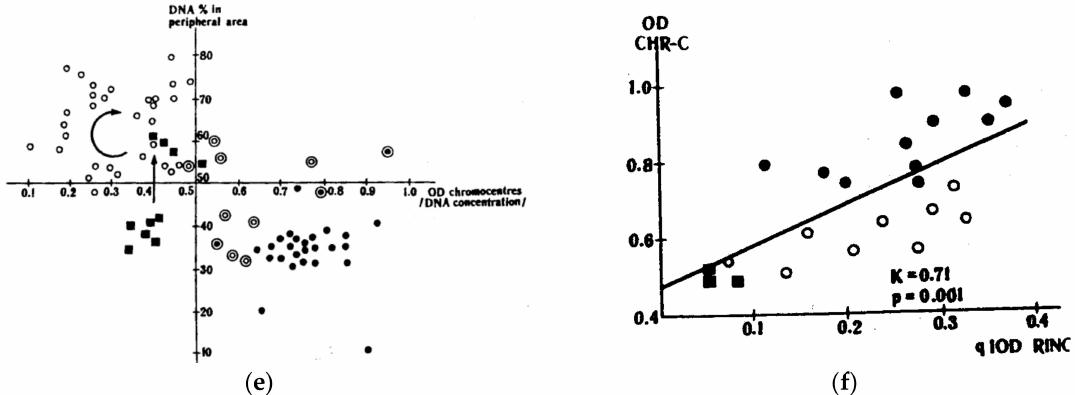
Figure 4. Chromatin changing in a chicken embryonic femur growth plate during transcriptional activation ( a , b ) and suppression ( c , d ) in the transient tissue—hypertrophic chondrocytes of a 14-day chicken embryo femur growth plate; ( e , f ) the results of morphometry showing the relationship between DNA concentration (OD) in dynamic chromocenters depending on the stage and vectorial position between the interactively discriminated perinucleolar heterochromatin shell (qIOD ring) and nuclear border in the active (light circles) and ageing (filled circles) chondrocytes; squares—mesenchymal precursors; double circles—differentiated, transient to ageing cells. ( f ) The concerted condensation of small chromocenters (Y-axis) and DNA accumulation in the perinucleolar ring formed by NORs and attached chromocenters (X-axis) in ageing cells (filled rings), and much weaker dependence on NORs in transcriptionally active chondrocytes (light circles). The mesenchymal precursors (squares in ( e , f )) are rather inert to these forces. ( a , c ) Scale bars = 5 µ m. Republished from